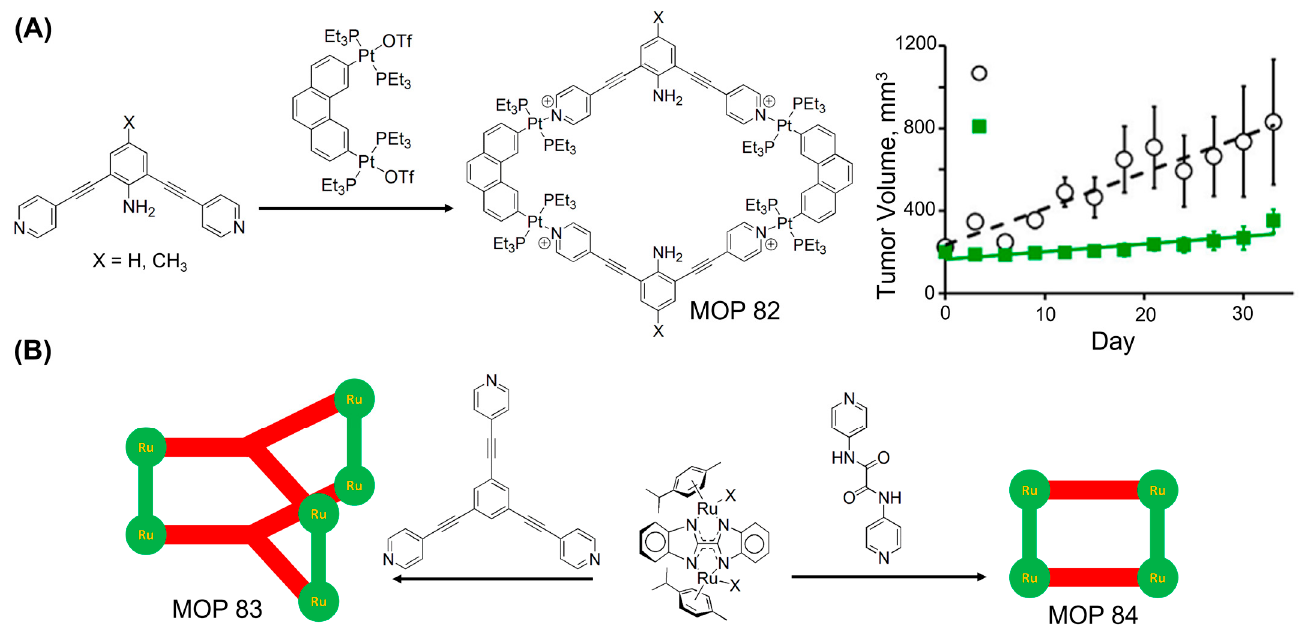
Figure 27. ( A ) Self-assembly of Pt-based supramolecular polygon MOP 82. Antitumor study of xenograft tumor bearing mice of breast cancer MDA-MB-231. ( B ) Use of diruthenium molecular spacer to prepare MOP 83 and MOP 84. Reprinted by permission from Refs. [213,215]. Copyright 2012 from American Chemical Society and copyright 2014 from National Academy of